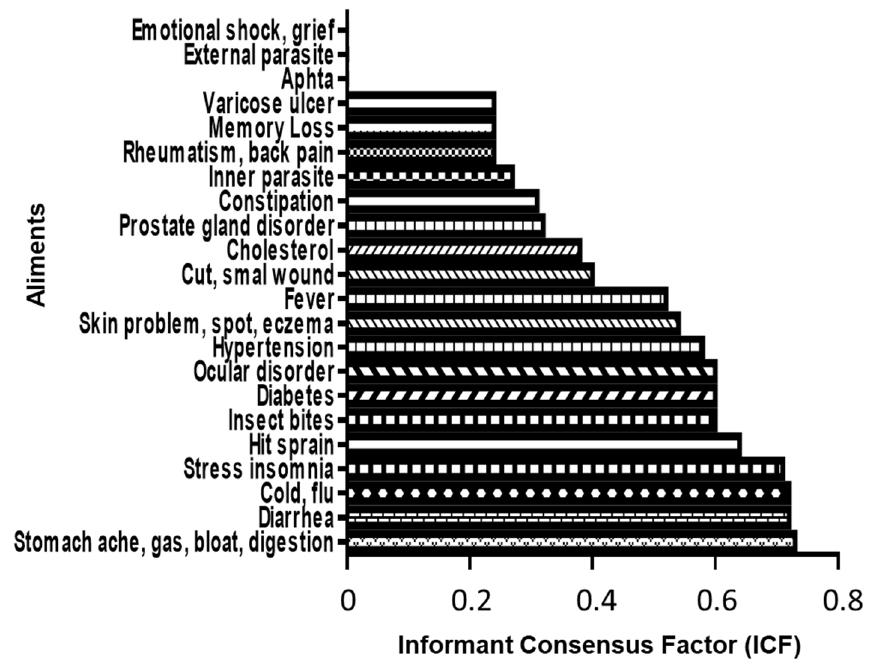
Figure 4. Alignment of categories in the ethnopharmacological survey. Informant consensus factor (ICF) is shown for each alignment. Table 1. Ailments and plants identified in the ethnopharmacological survey. Selected ailments are shown with their respective ICF and Fa, and the plants most used to treat them with their respective